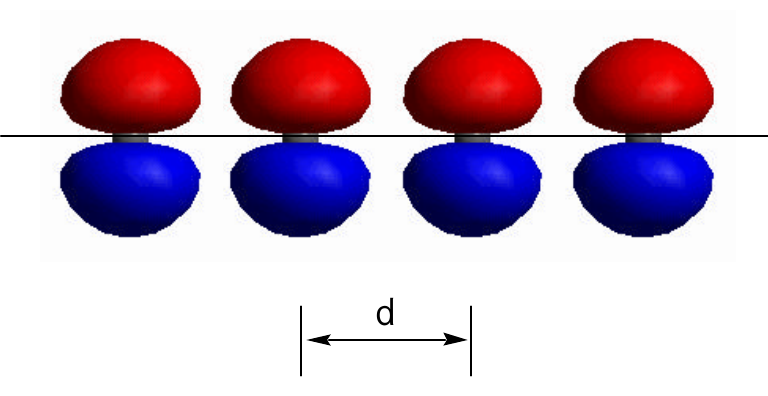
Figure 2: N -polyene, a simple one-dimensional analogue of the bulk solid as the designed model.